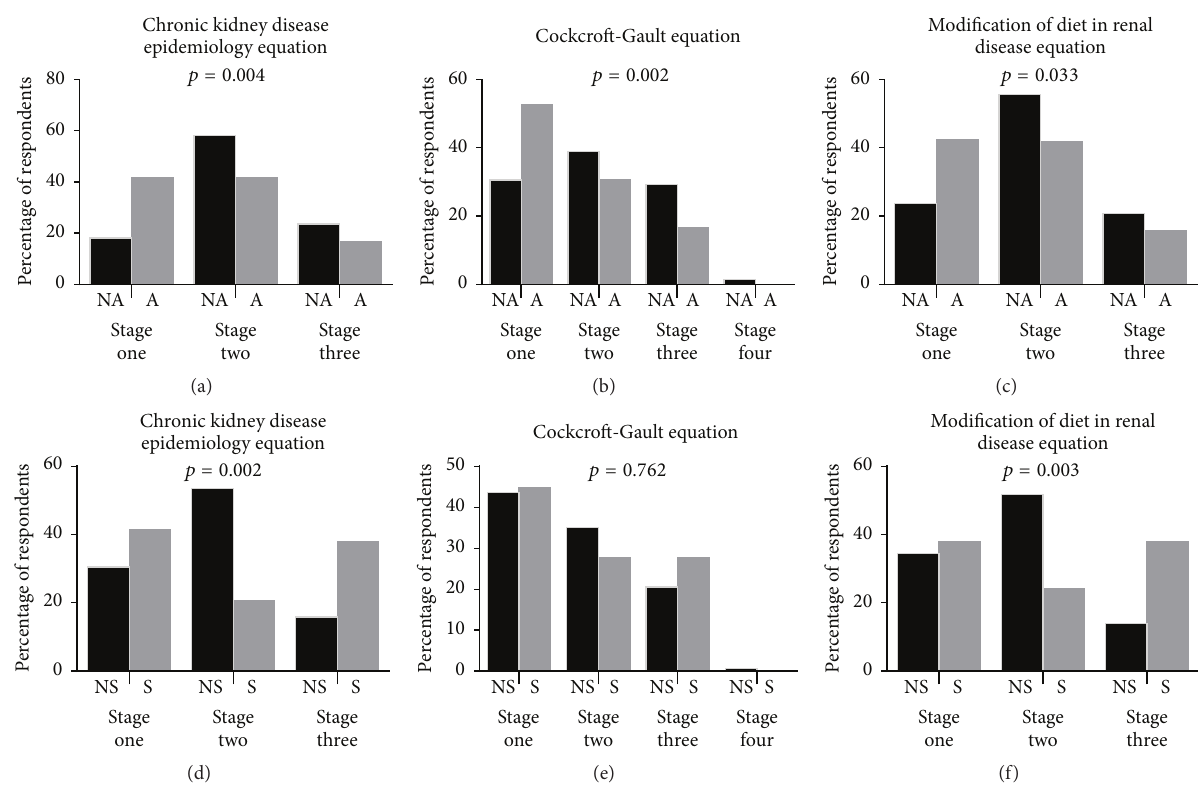
Figure 2: Estimates of the prevalence of CKD in the study population using the renal function equations stratified by alcohol consumption and smoking status. NA: nonalcoholic, A: alcoholic, S: smoker, and NS: